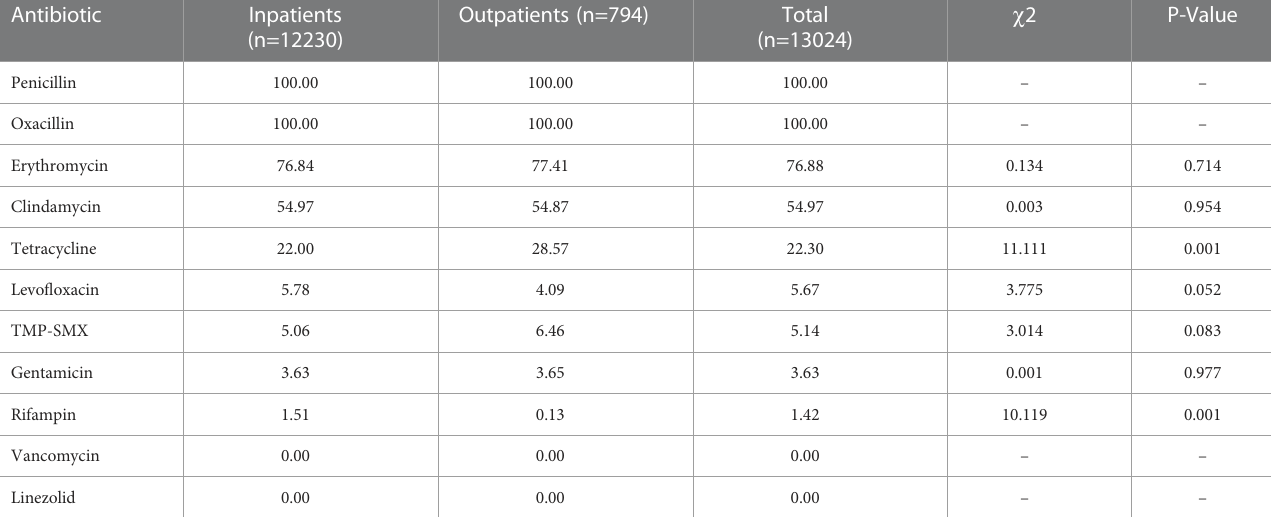
TABLE 2 Antimicrobial resistance rates of MRSA strains in inpatients and outpatients. Antibiotic